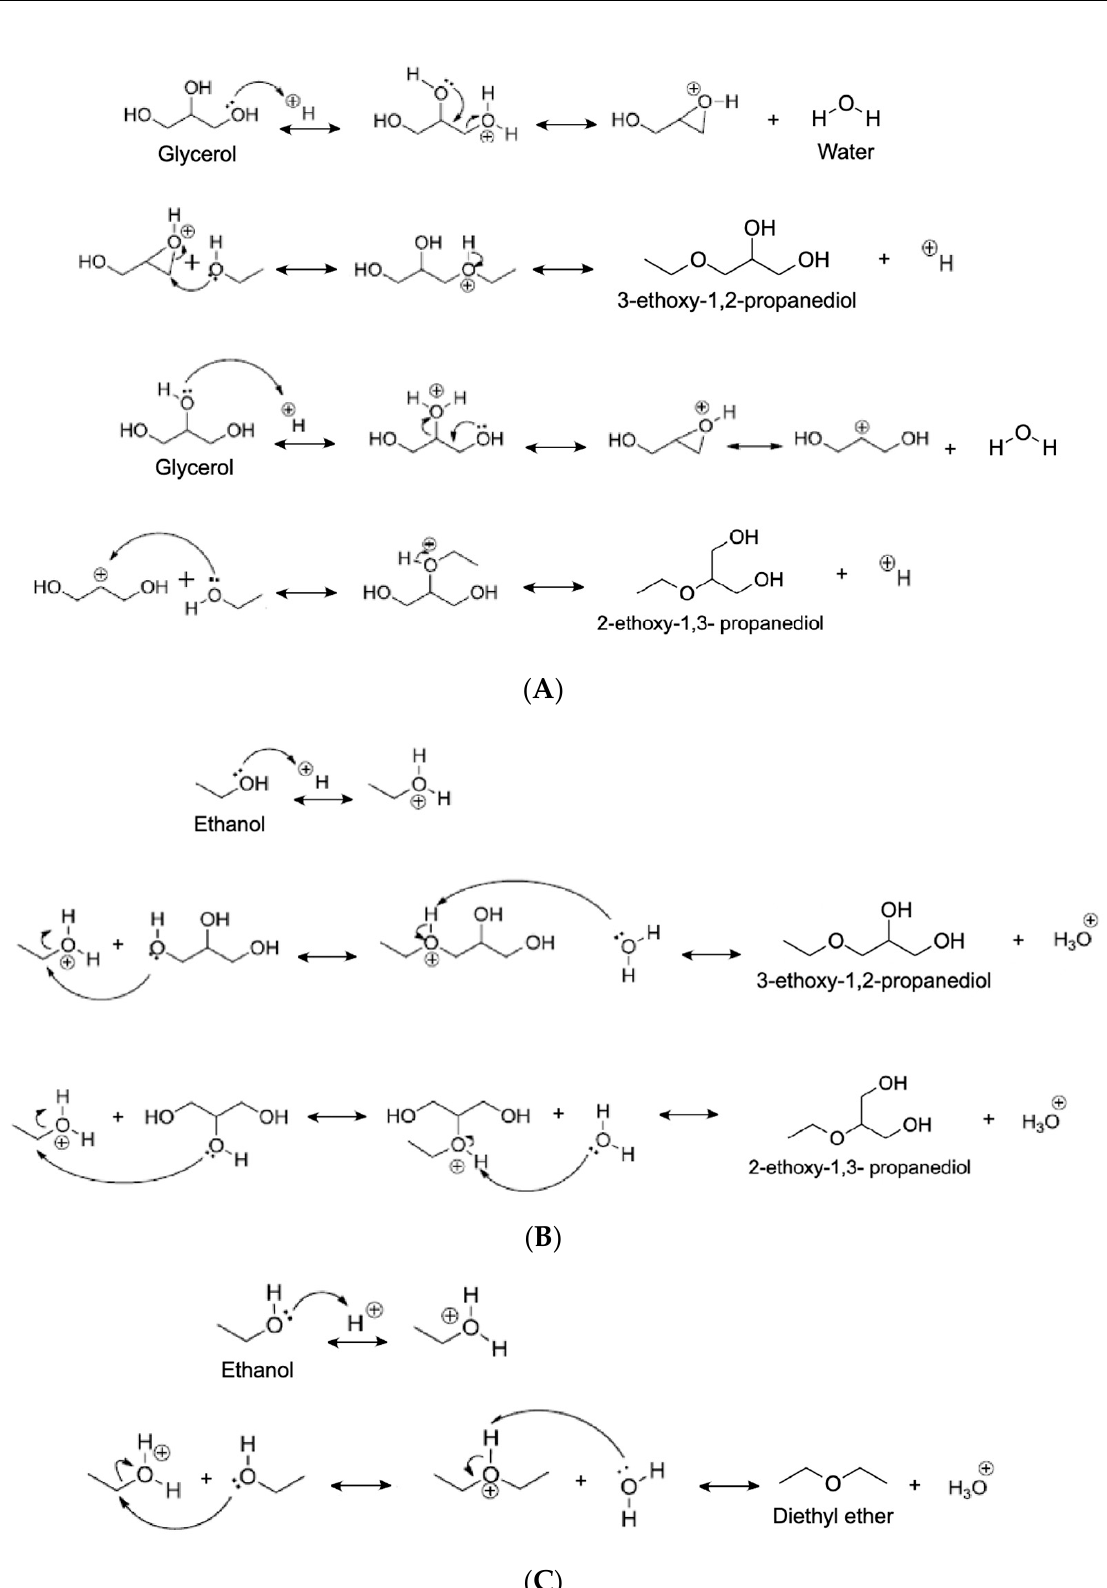
Figure 8. ( A ) Proposed mechanism in developing 3-ethoxy-1,2-propanediol and 2-ethoxy-1,3- propanediol via the protonation of glycerol [118]; ( B ) Proposed mechanism for the protonation of ethanol as the mechanism in developing 3-ethoxy-1,2-propanediol and 2-ethoxy-1,3-propanediol [118]; ( C ) Proposed mechanism for the formation of diethyl ether [118].